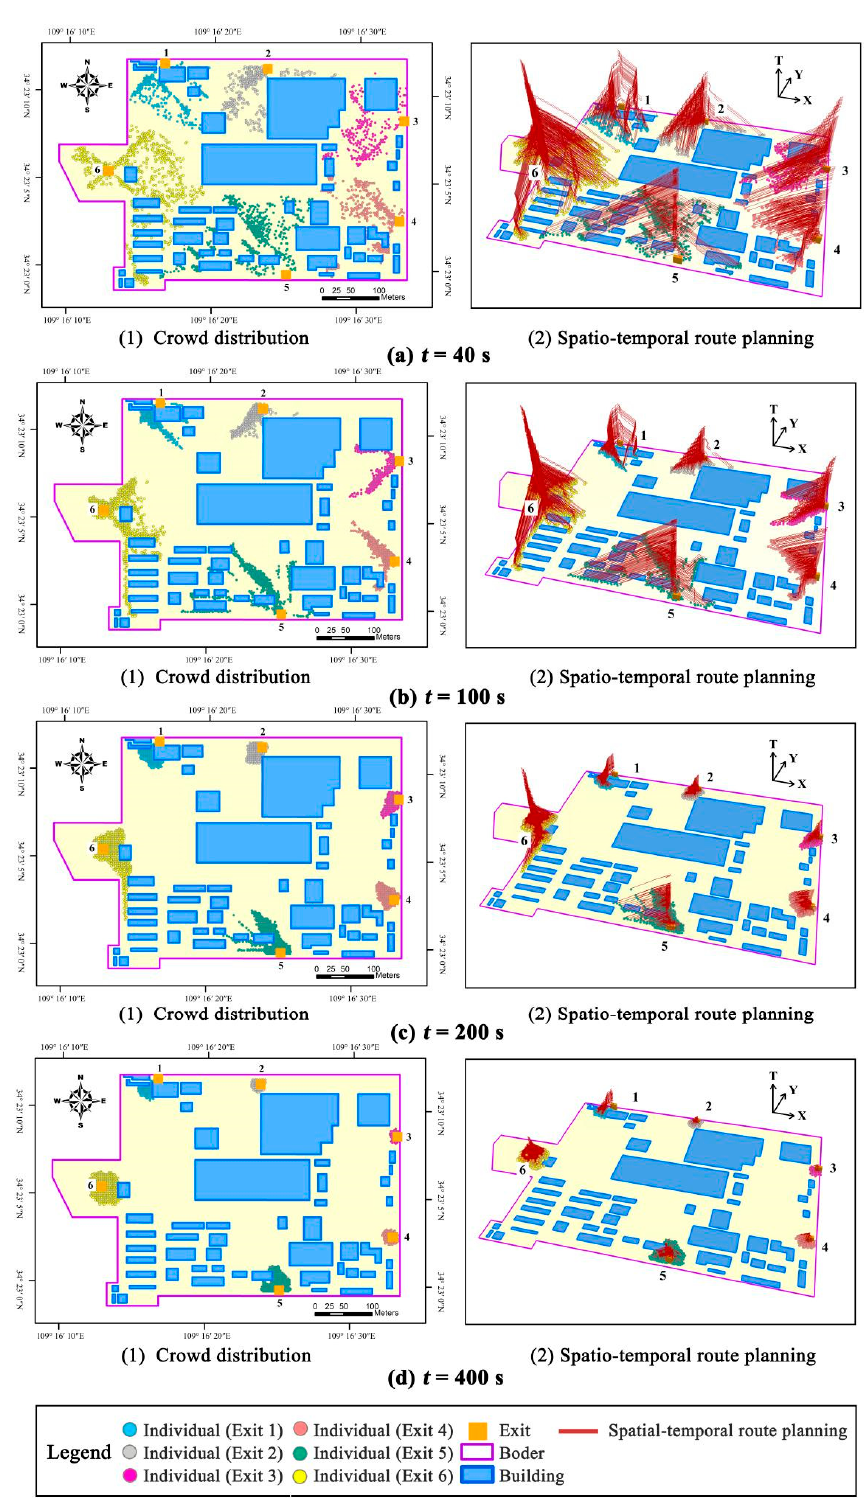
Figure 5. Crowd evacuation simulation snapshots ( a – d ).